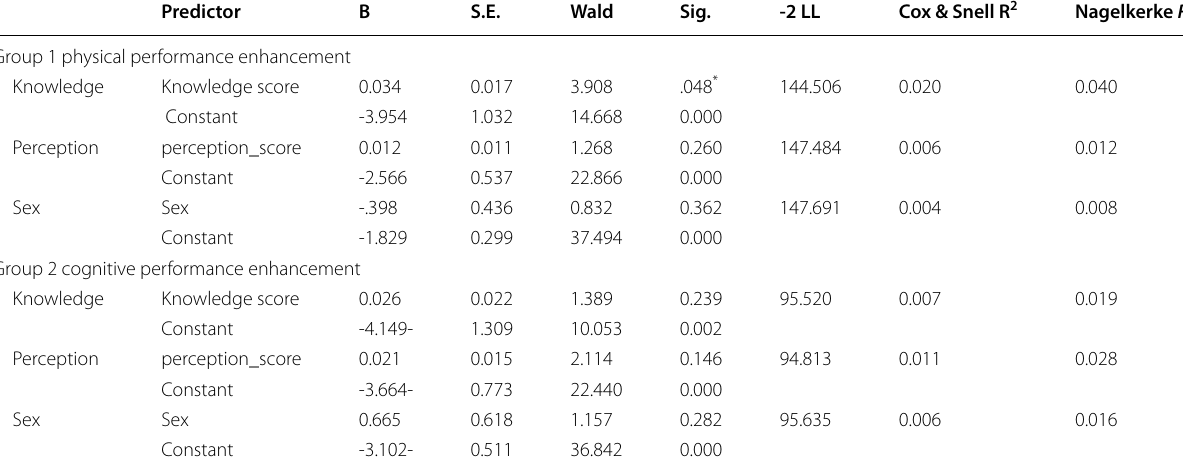
S.E standard error, *significant if p